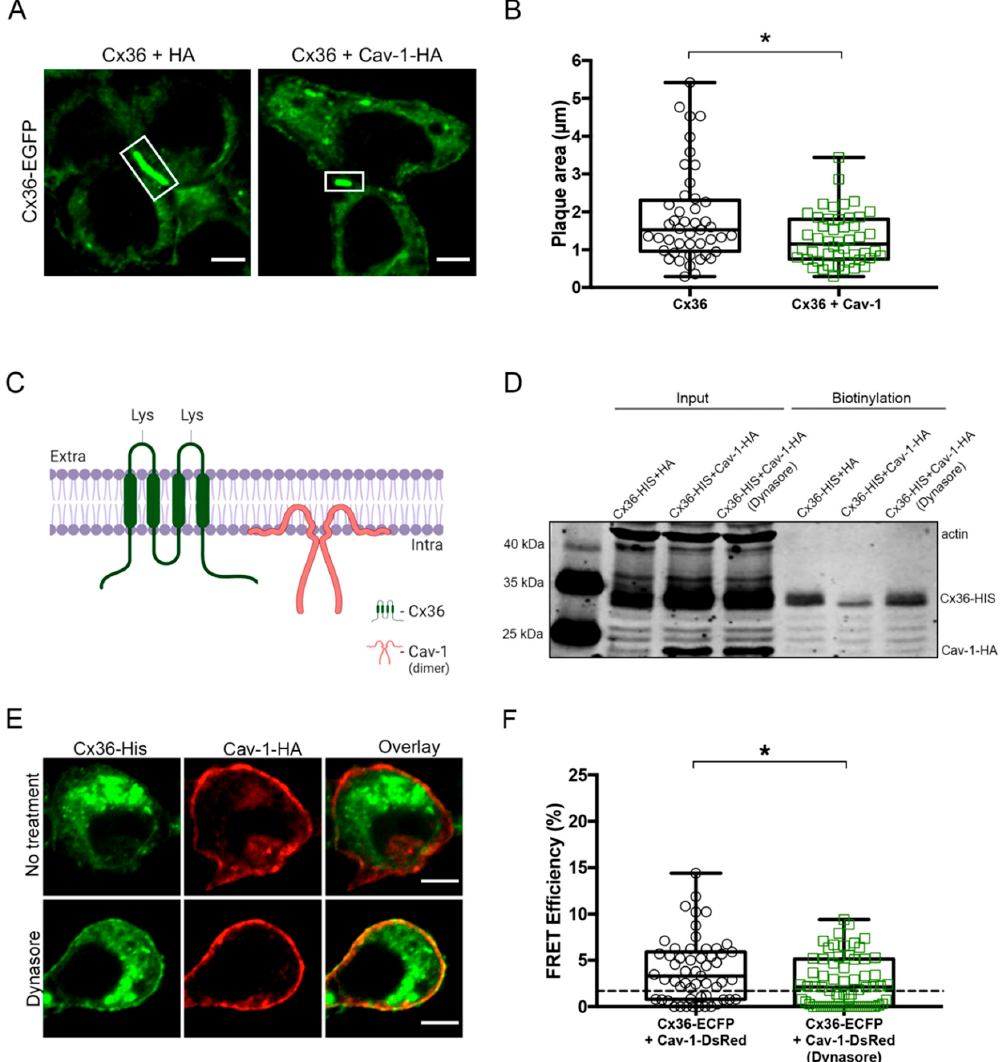
Figure 5. Cav-1 regulates levels of Cx36 at the membrane. ( A ) Representative images of Cx36 gap junction plaques (in white boxes) in live cells transfected with Cx36-EGFP and HA or Cx36-EGFP and Cav-1-HA. Scale bar: 5 µ m. ( B ) Gap junction plaque areas of cells double transfected with Cx36-EGFP and Cav-1-HA were significantly reduced when compared to cells transfected with Cx36-EGFP and HA. Error bars show the minimum and maximum values. Sample sizes were the following: Cx36-EGFP: n = 45; Cx36-EGFP and Cav-1-HA: n = 48. ( C ) Topological representation of Cx36 and Cav-1 structures. Unlike Cav-1, Cx36 possesses two extracellular loops which can undergo cell surface biotinylation. The image was created with BioRender.com. ( D ) Cell surface biotinylation assay displaying the effect of Cav-1 on levels of Cx36 at the membrane. Total cell lysates (Input) show expression of both Cx36 and Cav-1. The streptavidin pull-down fractions (Biotinylation) show that membrane levels of Cx36 were depleted in cells double transfected with Cav-1. Treatment with Dynasore restored membrane levels of Cx36 to baseline. Anti-HIS and anti-HA antibodies were used to detect Cx36 and Cav-1 proteins, and an anti-ß-actin antibody was used as an internal control. ( E ) Cx36 and Cav-1 transfected cells pre and post Dynasore treatment. Increased membrane expression of Cx36 can be observed post treatment. Scale bar: 5 µm. ( F ) FRET efficiencies of Neuro 2a cells transfected with Cx36 and Cav-1 with and without Dynasore treatment. The threshold of 1.7% (equals to 10 nm) is represented by the dotted line. Error bars show the minimum and maximum values. Sample sizes were the following: Cx36-ECFP + Cav-1-DsRed: n = 55; Dynasore: n = 64. * p < 0.05.